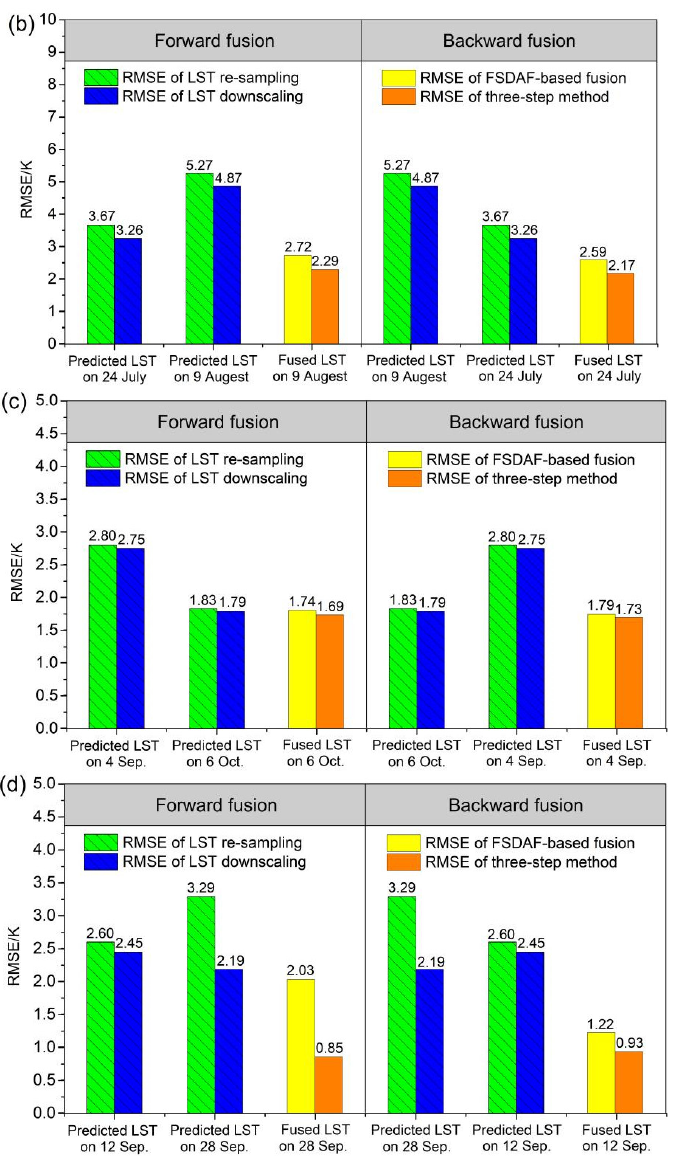
Figure 10. Impacts of two kinds of downscaling methods on the predicted LST image at t p during the forward fusion and the backward fusion in two days in the same year: ( a ) Images A1 and A2; ( b ) Images A3 and A4; ( c ) Images B1 and B2; ( b ) Images B3 and B4.